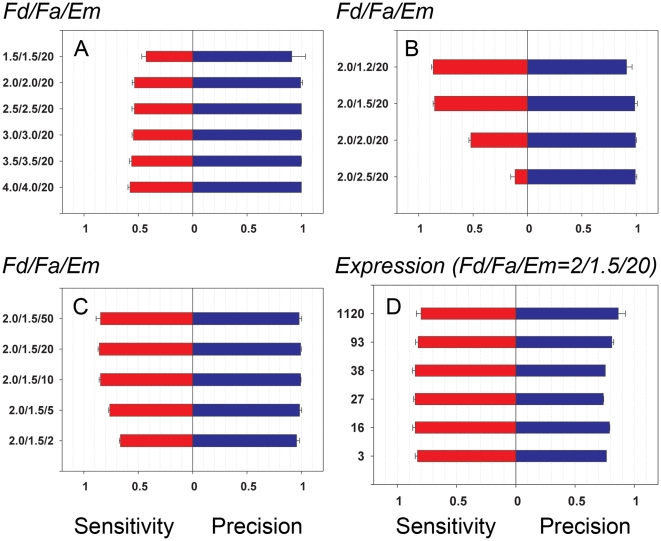
The influence of restrictions on the quality of differentially expressed genes detection (Fd - the level of introduced changes, analysis restrictions on the minimal level of expression – Em, and fold change Fa).All results were obtained by application of the Associative analysis (see Materials and Methods) to the analysis of data with controlled changes in expression of part of the genes. Sensitivity and Precision are shown with bars of red and blue color correspondingly. A–B) Dependence of the Sensitivity on the relative values of introduced changes (fold change Fd) and minimal fold change restriction for Associative analysis (Fa). Only fold change used in Associative analysis smaller than introduced fold change Fd yielded highest Sensitivity and Precision. C) Decrease of the Sensitivity with decrease of the minimal expression level to 2SD of the normal distribution of technical noise. D) Relative stability of the quality of estimations over the whole range of gene expression levels.